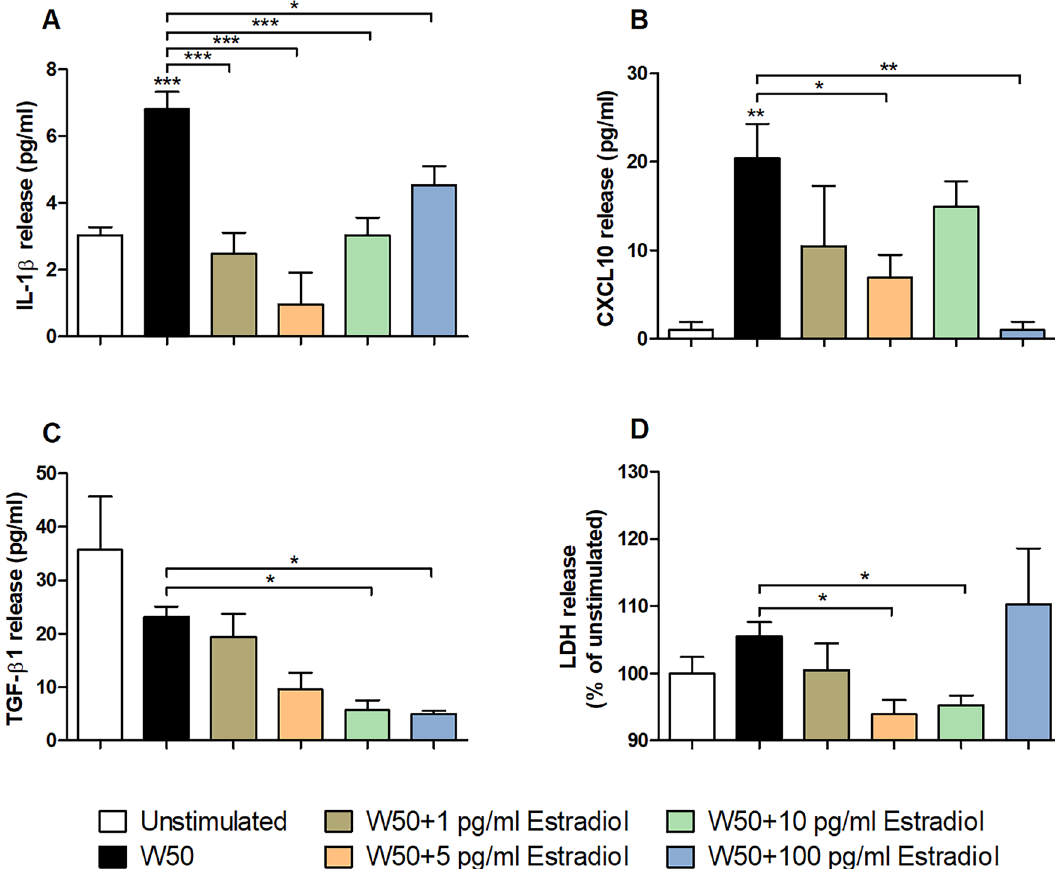
Figure 4. Estradiol alters P. gingivalis induced cytokine release. IL-1β ( A ), CXCL10 ( B ), TGFβ-1 ( C ) and LDH ( D ) release from gingival epithelial cells infected with P. gingivalis with or without estradiol (1, 5, 10 and 100